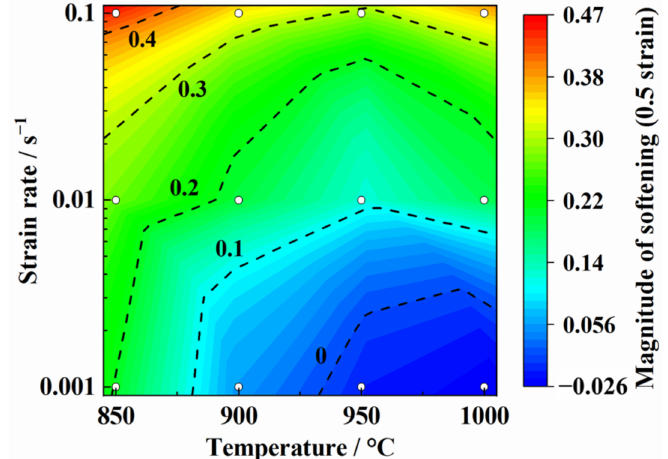
Figure 6. Flow softening coefficients at different temperatures and strain